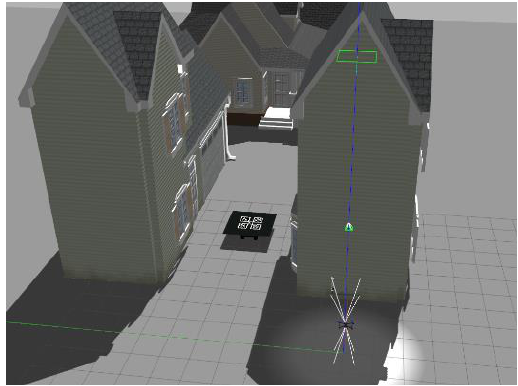
Figure 5. Gazebo simulation environment. The local trajectory is visualized in Rviz, as shown in Figure 6. The height of the obstacles in the figure can be seen intuitively through colors: red represents the lowest, while purple represents the highest. It can be seen in Figure 6 that the algorithm used here can model the obstacles accurately to plan a collision-free trajectory between the UAV and the moving